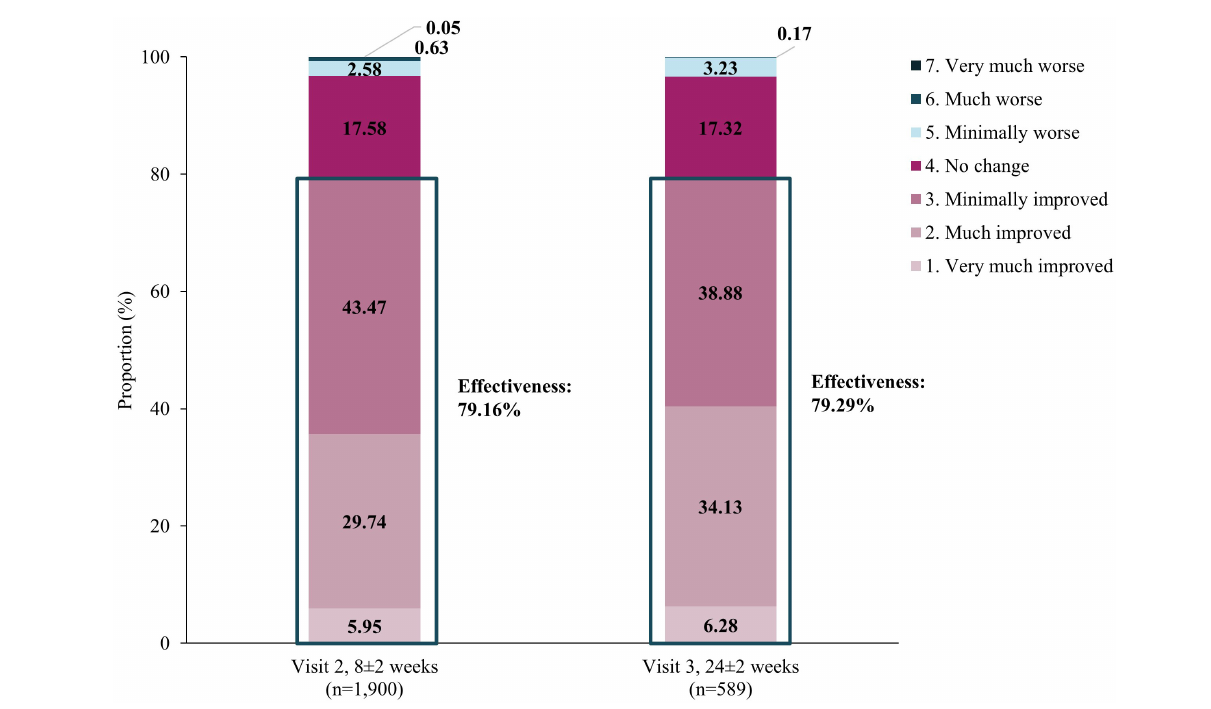
FIGURE4 Effectiveness using CGI-I assessment. Effectiveness of vortioxetine was defined as the proportion of patients that showed improvements in CGI-I scores from baseline at Visits 2 (8 ± 2 weeks) and 3 (24 ± 2 weeks). Effectiveness was calculated by classifying “Improved” categories as “effective”, and categories under “No change” and “Worse” as “ineffective”. CGI-I, Clinical Global